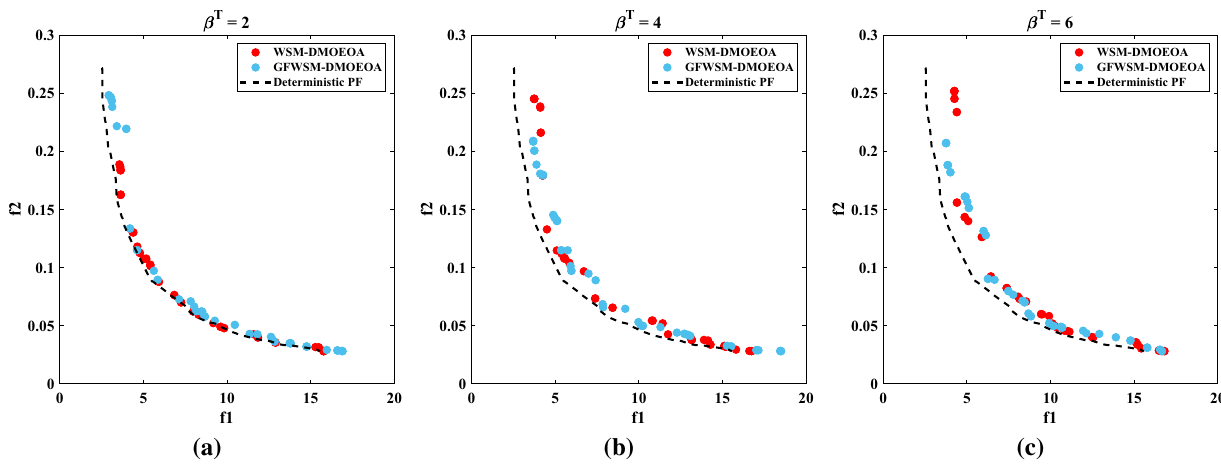
Fig. 10 The best Pareto optimal fronts obtained by WSM-DMOEOA, GFWSM-DMOEOA and DMOEOA on MORBDO test example 2 under different target reliability